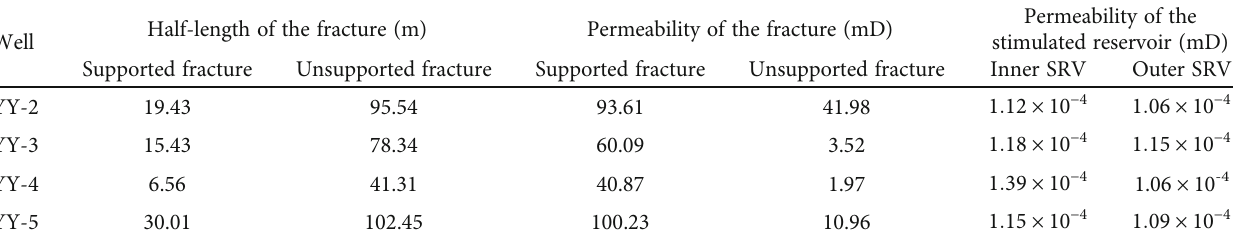
Table 4: Parameter inversion results for wells YY-2 ~ YY-5 (considering the uneven support of fractures). Well